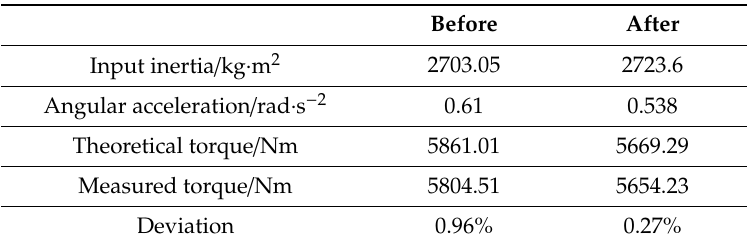
Table 1. Comparison of results before and after correction.